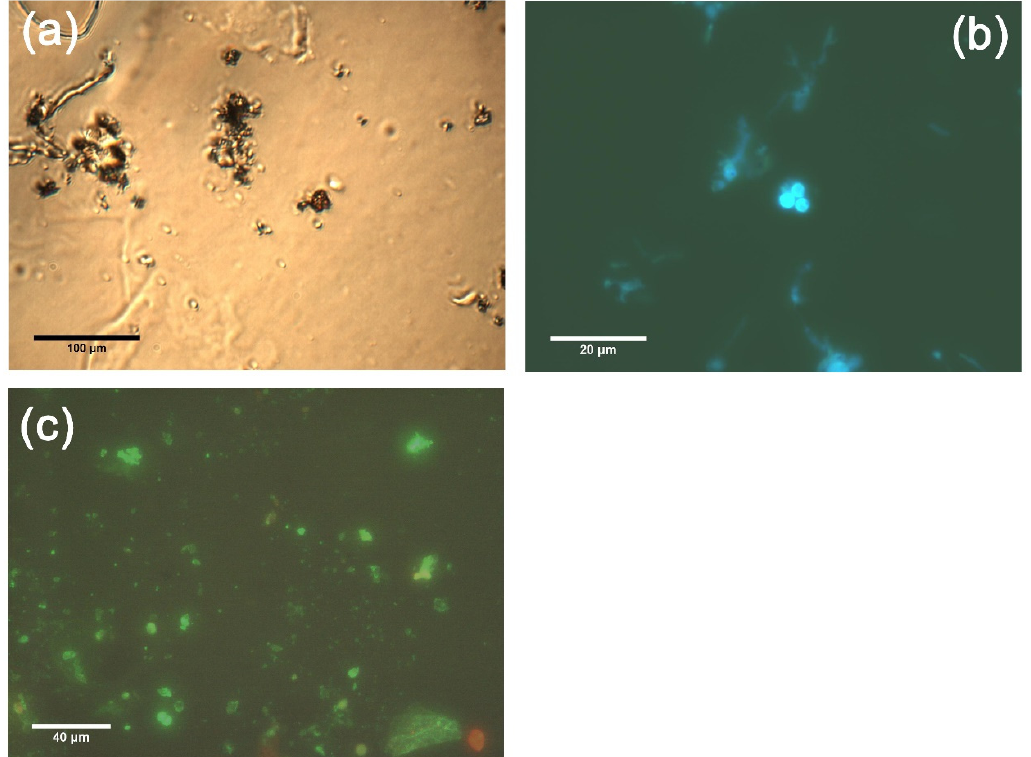
Figure 5. Bright field ( a ) and epifluorescence ( b , c ) microscope images of sample S3 from black/brown discoloration on tile T3.